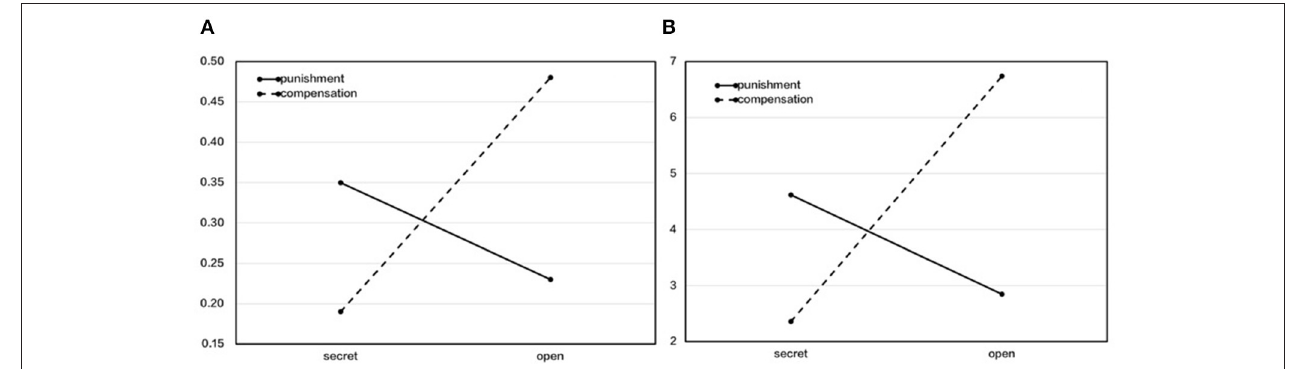
FIGURE 4 | The difference in transfer rates and amounts between punishment and compensation under the contexts of secret and open when participants were free to choose. (A) Transfer rate. (B) Transfer amount.